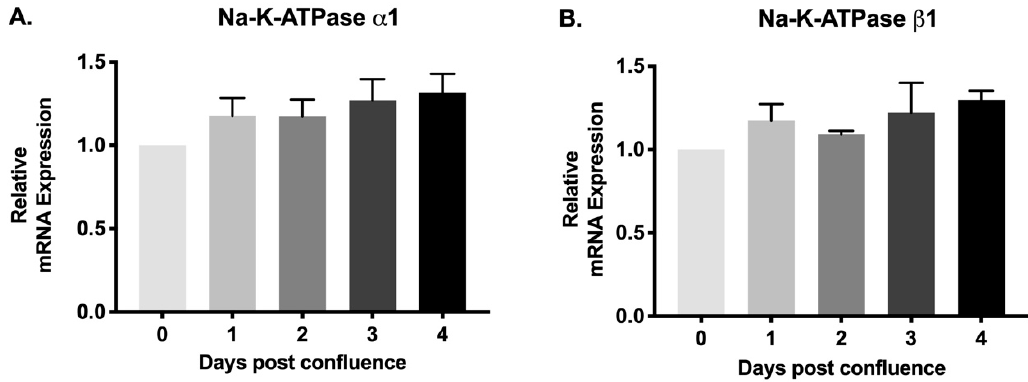
Figure 5. Quantitative real-time polymerase chain reaction (qRT-PCR) analysis of IEC-18 cells on different days of post confluence. Values are relative to 0-day and normalized to β -actin. ( A ). Na-K-ATPase α 1. ( B ). Na-K-ATPase β 1. Values are represented as mean ± SEM, n = 4.